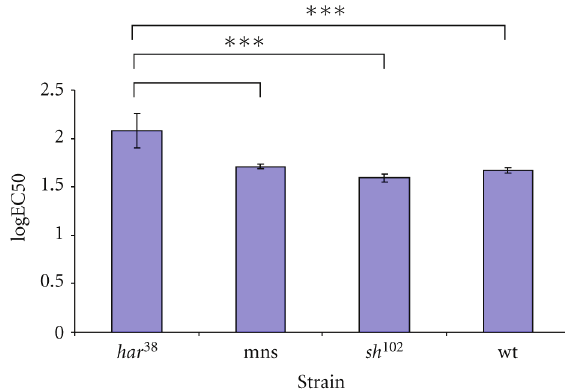
Figure 2: logEC50 of xenon for di ff erent strains of flies (mean ± SE). The logEC50 in na [ har 38 ] flies is significantly higher than in the other three